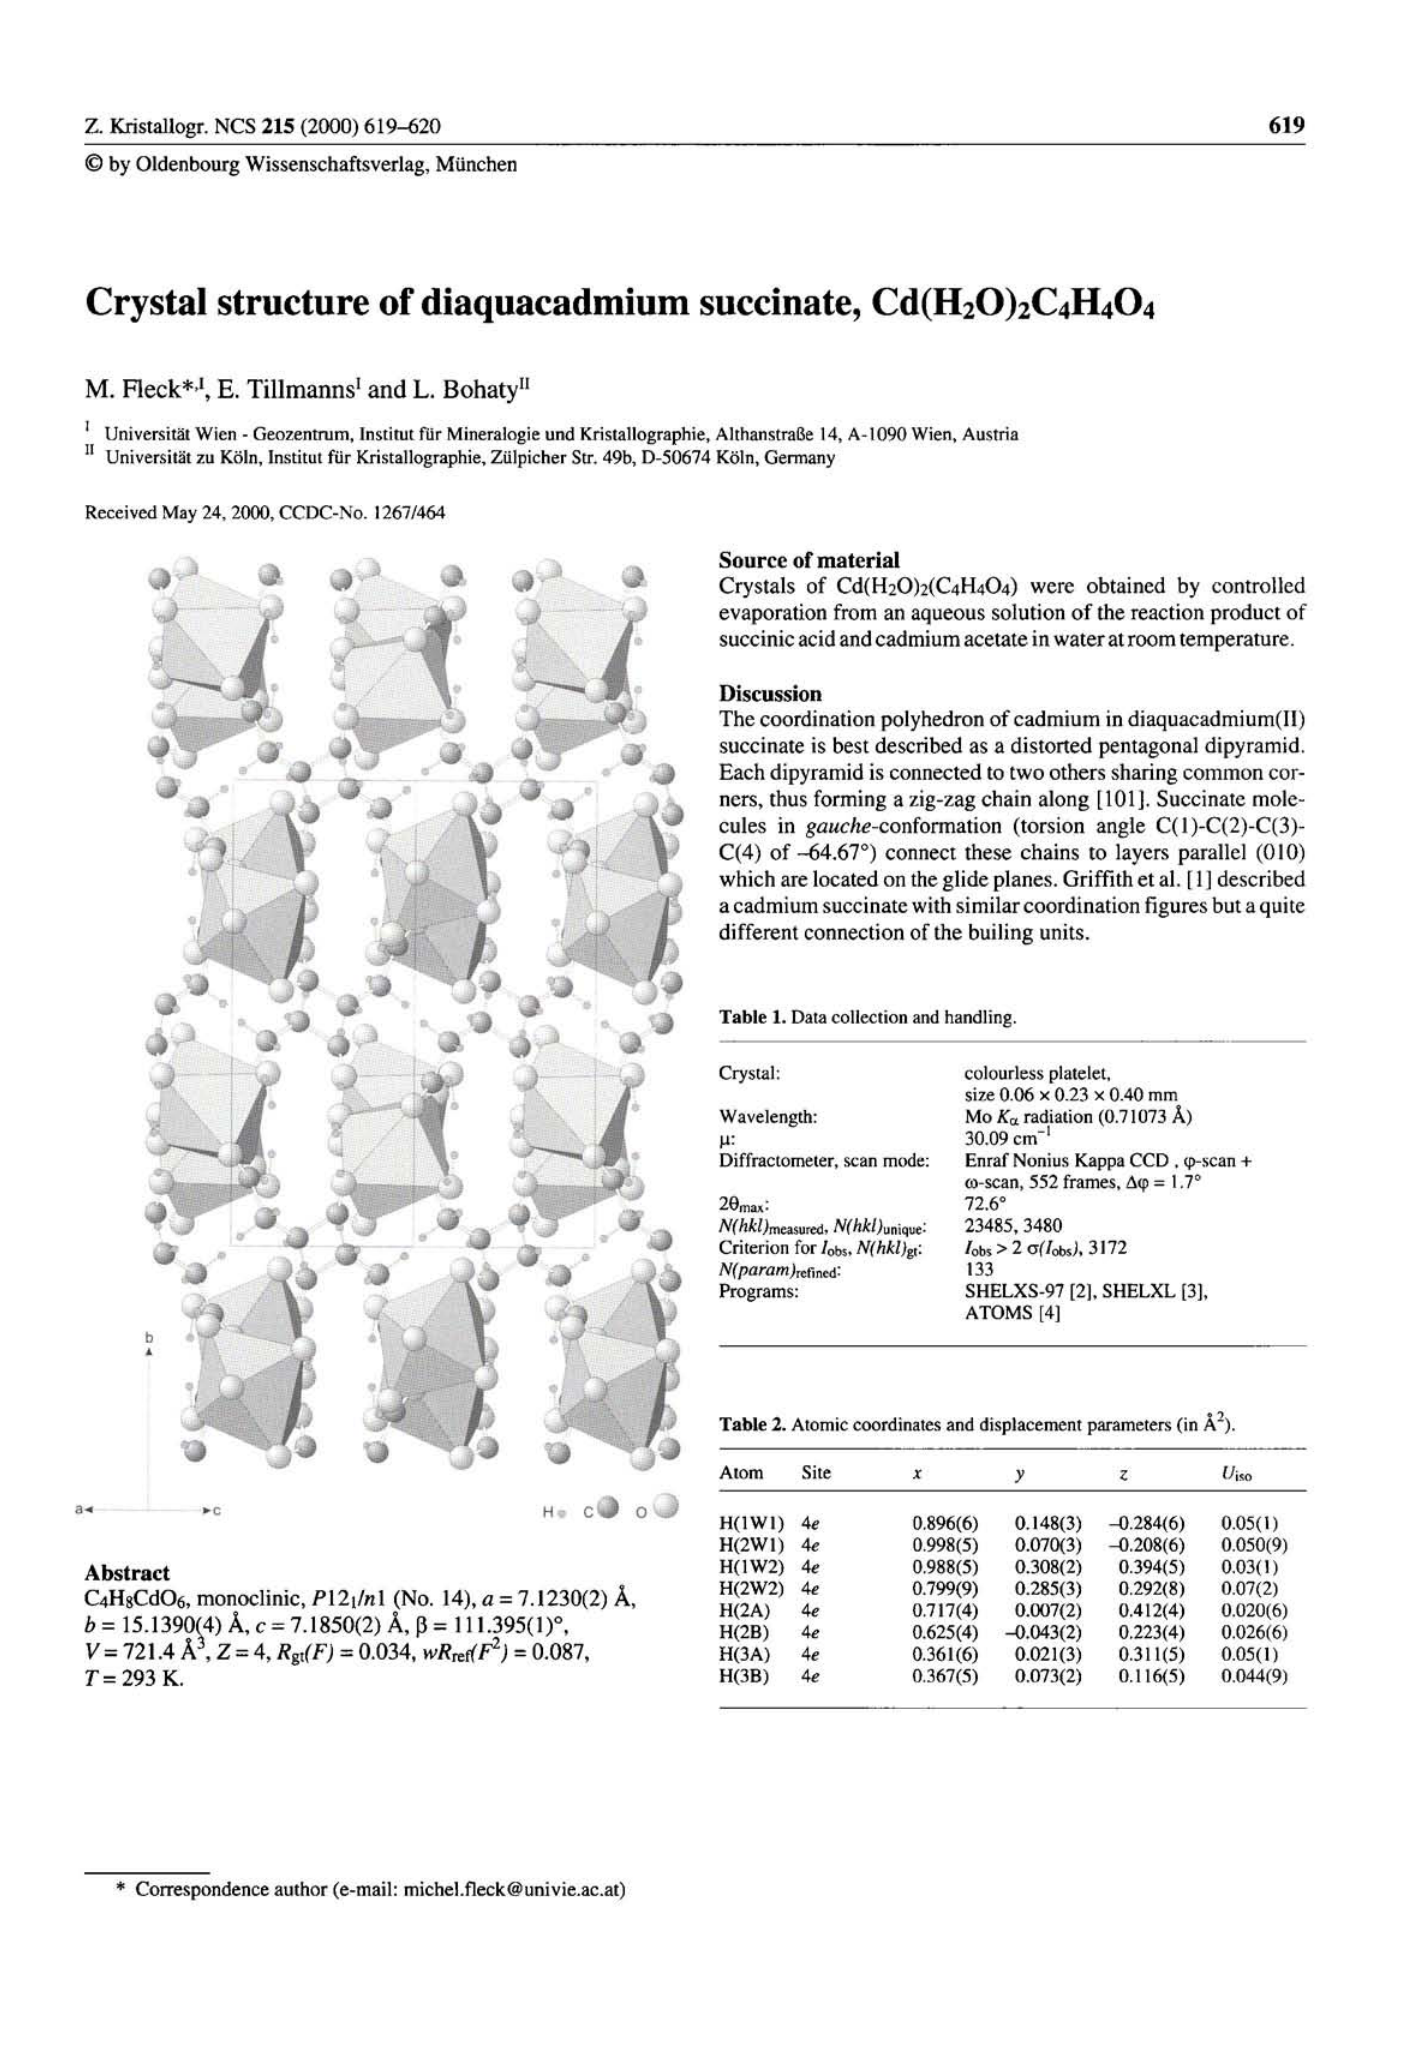
Table 1. Data collection and handling.